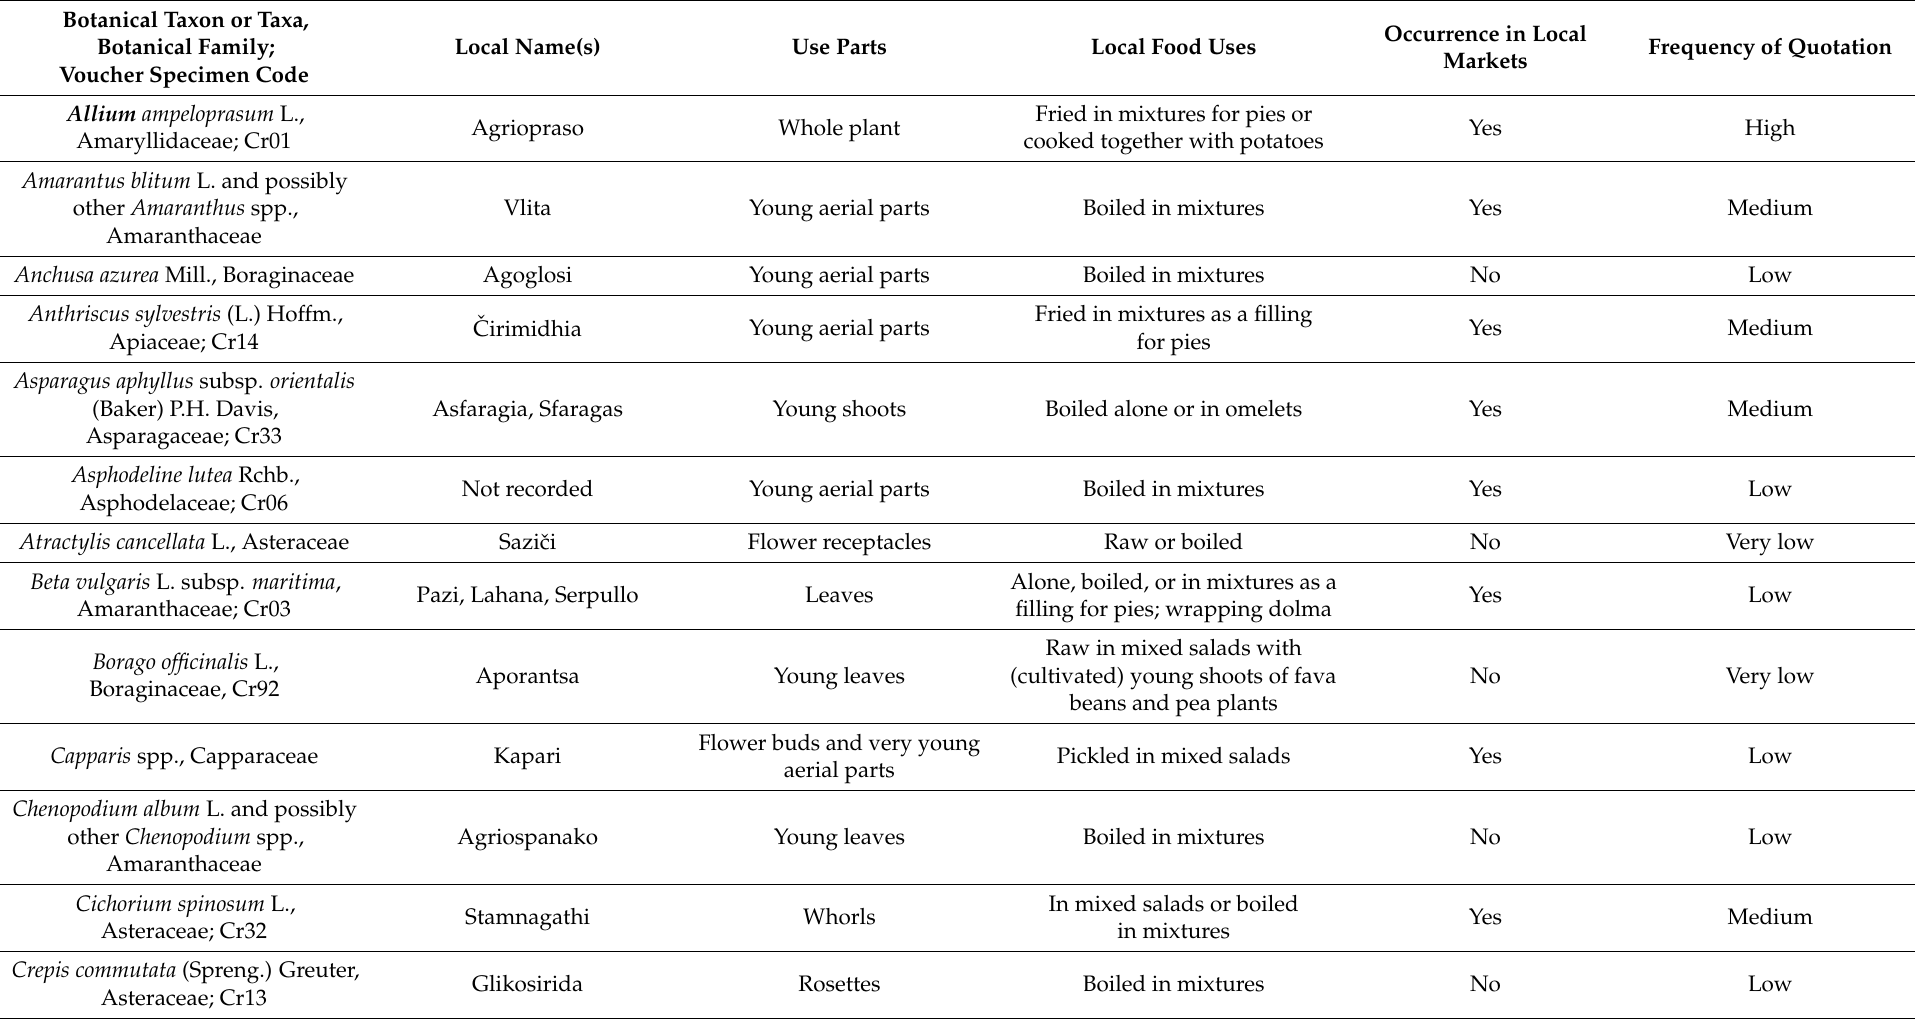
Table 2. Recorded Cretan wild greens, their folk names, local culinary uses, occurrence in markets, and frequency of